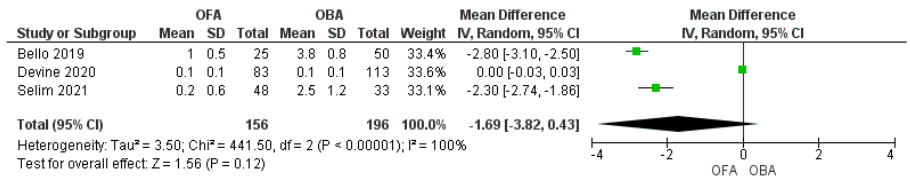
Figure 6. Forest plot of mean difference of pain at 24 h comparing opioid − free anesthesia and opioid − based anesthesia [16,17,19].